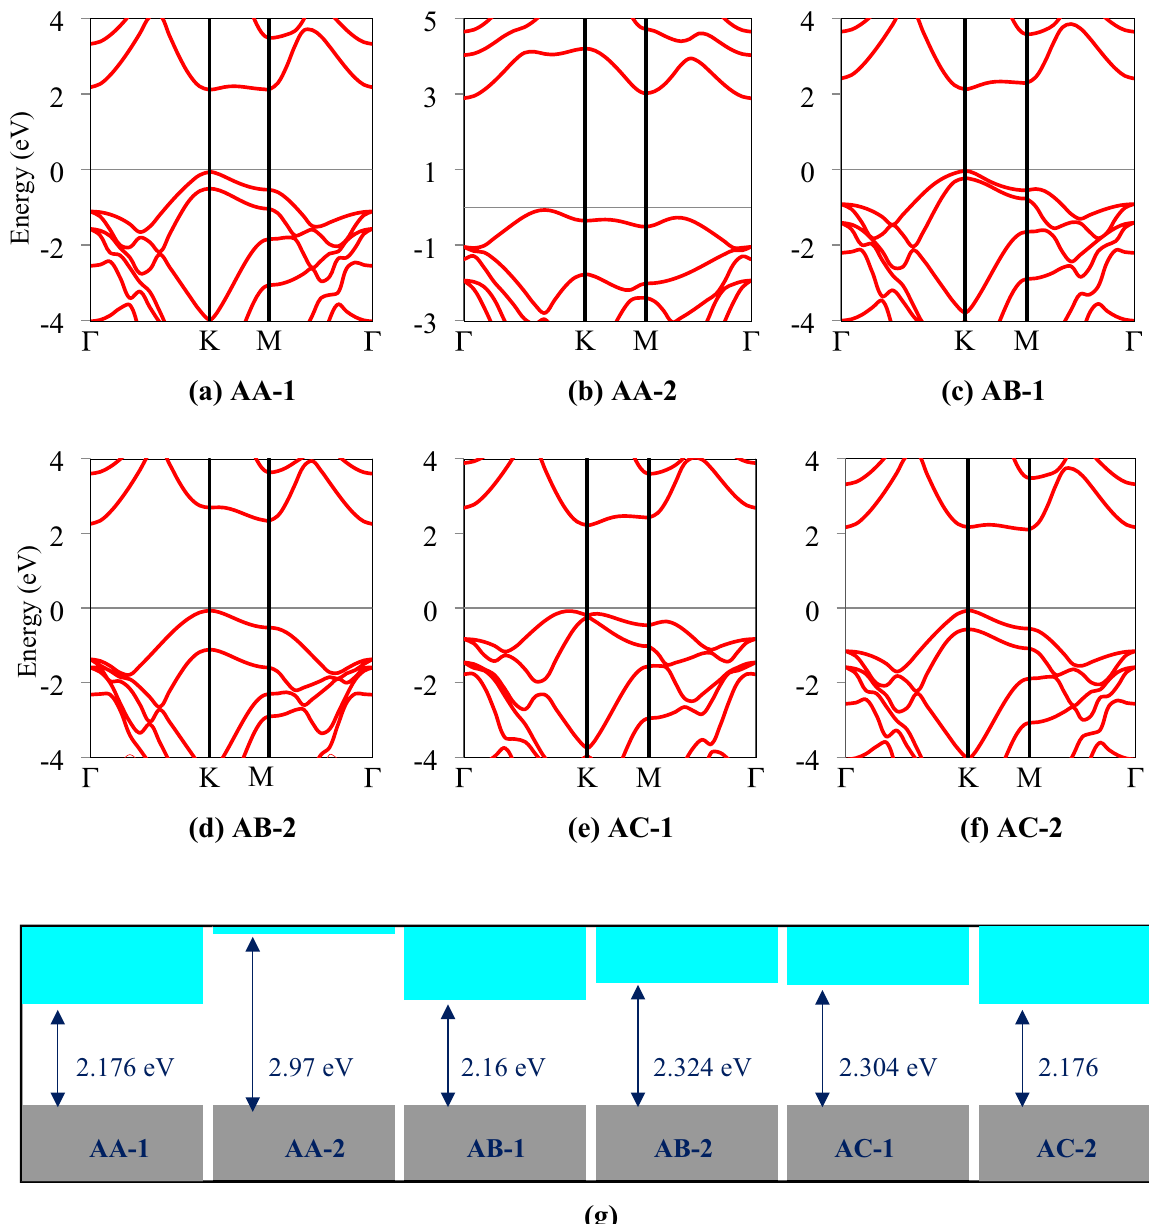
Figure 2. Electronic band diagrams of six stacking configurations of the SiC/AlN van der Waals heterostructure: ( a ) AA-1, ( b ) AA-2, ( c ) AB-1, ( d ) AB-2, ( e ) AC-1, ( f ) AC-2. ( g ) Calculated electronic band gaps of the six configurations of the